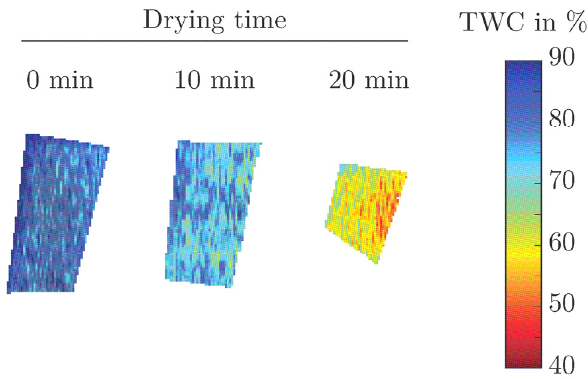
Figure 8. TWC distribution maps of a kidney sample during the drying process.